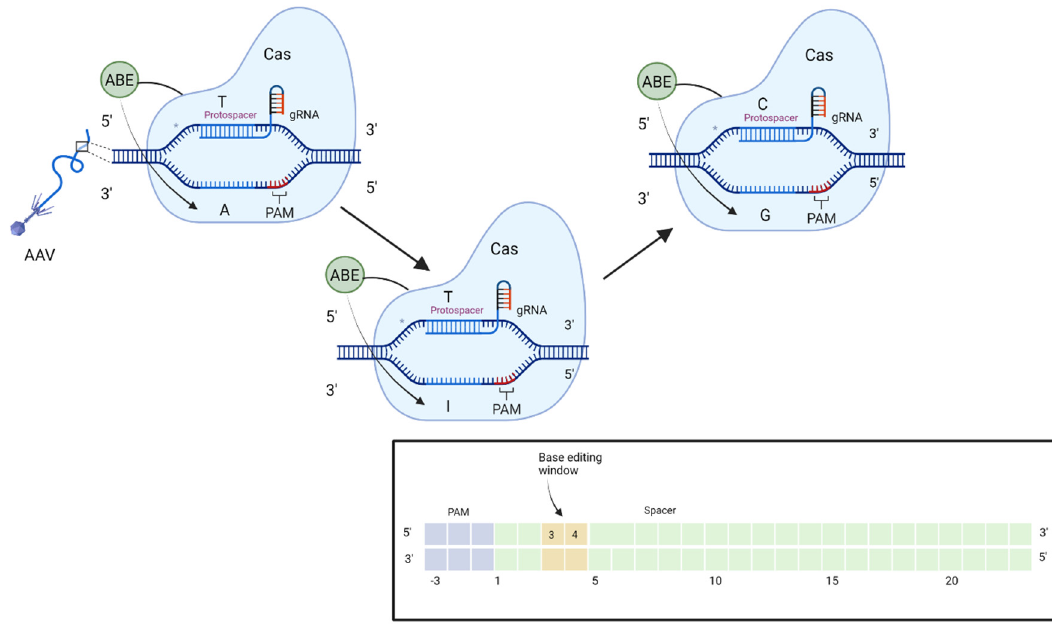
Figure 5. The base editing mechanism, which mediates an A to G conversion via an inosine intermediate. The CasMini protein has a maximal editing efficiency 3–4 base pairs in the 3 ′ direction to the PAM site. Created with BioRender.com (accessed on 18 August 2022).